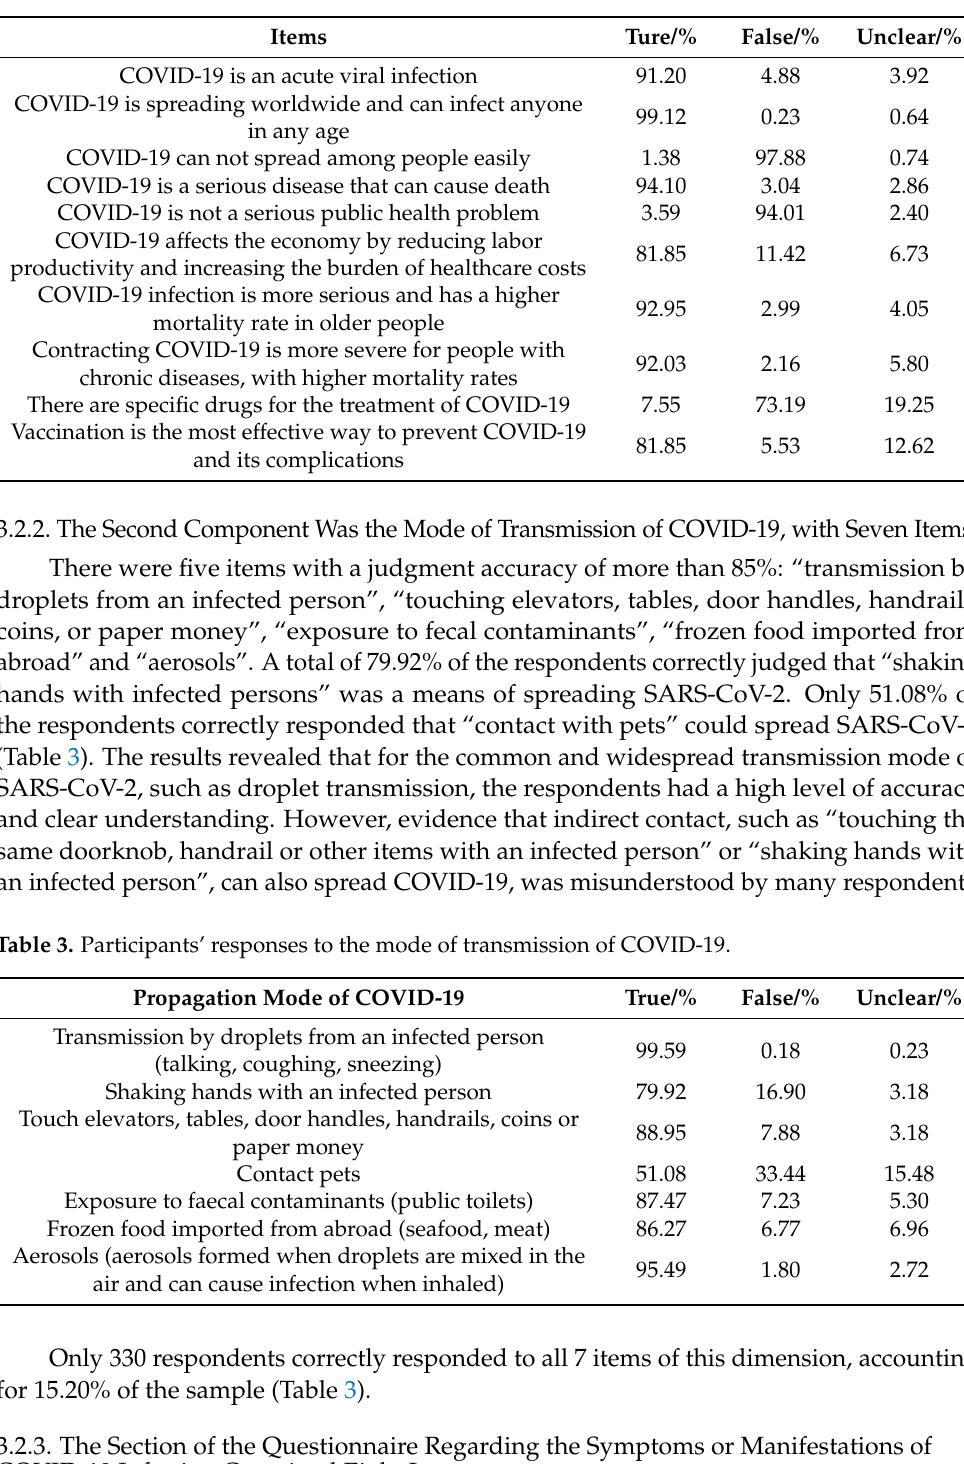
Table 2. Participants’ responses to COVID-19 related knowledge.